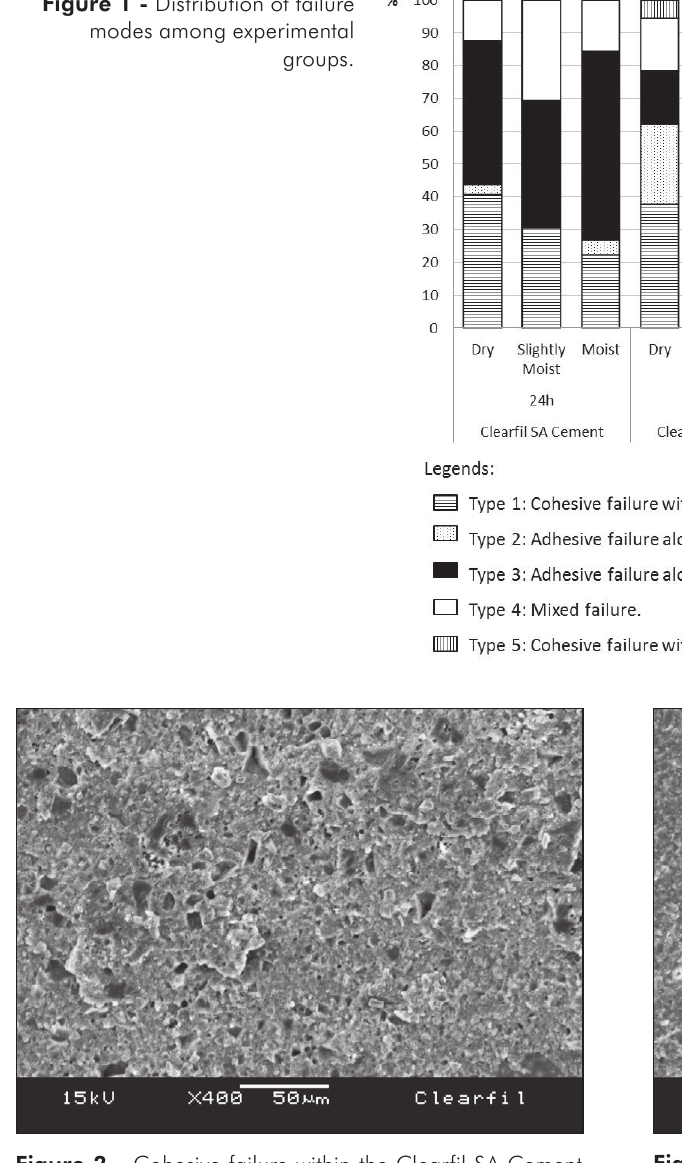
Figure 1 - Distribution of failure modes among experimental groups.